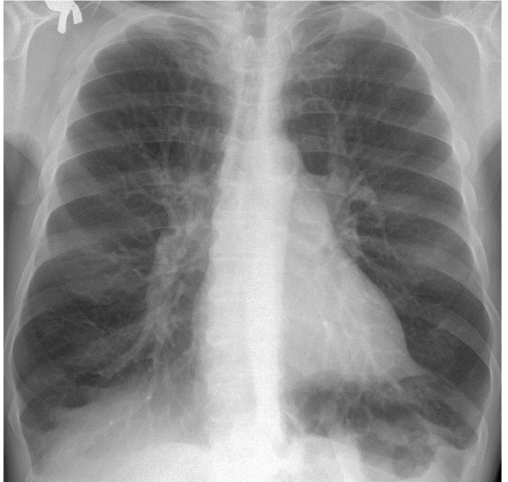
Figure 7. Selecting the portion of interest of the lungs of patient EF.